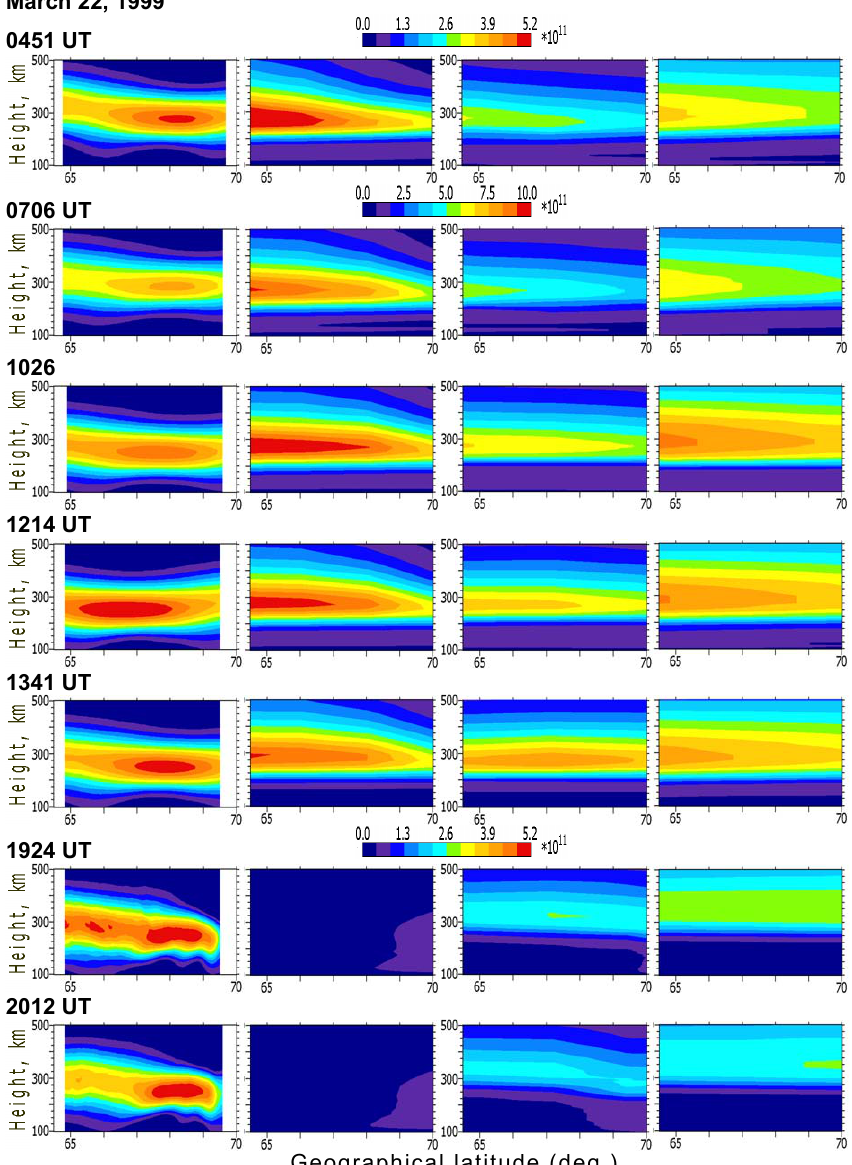
Fig. 7. Same as Fig. 3, on 22 March 1999.